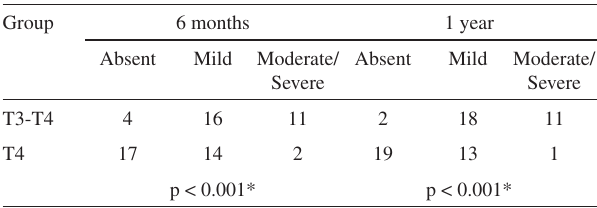
Table 2 – Incidence and severity of compensatory hyperhidro- sis in the two patient groups following